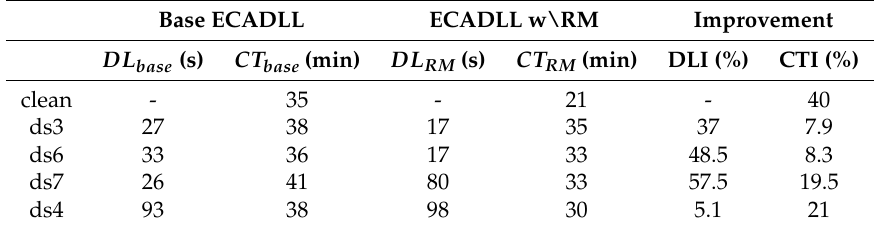
Table 3. Numerical results for improvement of detection delay and computational load. Legend: DL = Detection Latency. CT = Computational Time. DLI = Detection Delay Improvement. CTI = Computational Time Improvement. Base ECADLL ECADLL